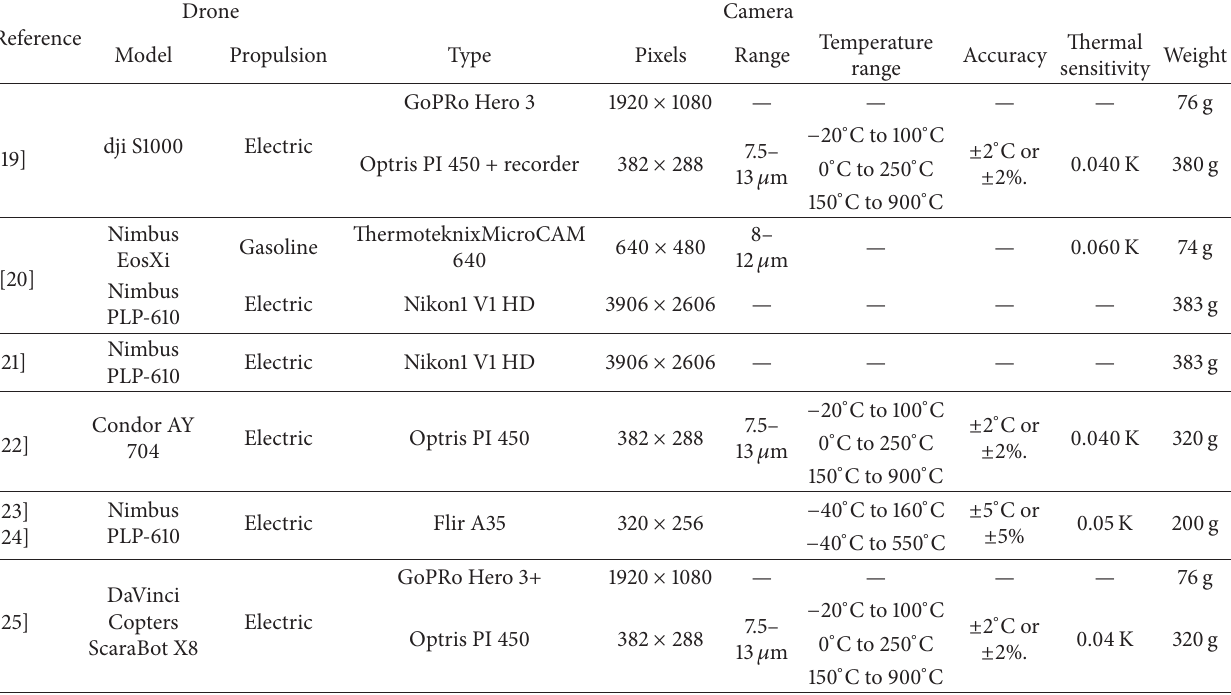
Table 1: Drones and cameras employed in aerial